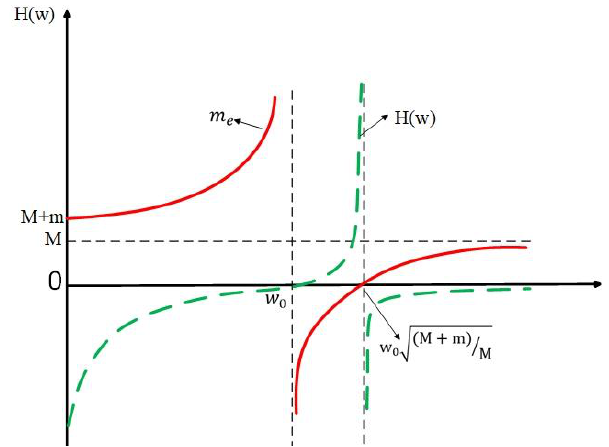
Table 1. The relationship between system dynamic equivalent mass 𝑚 𝑒 and excitation frequency w.